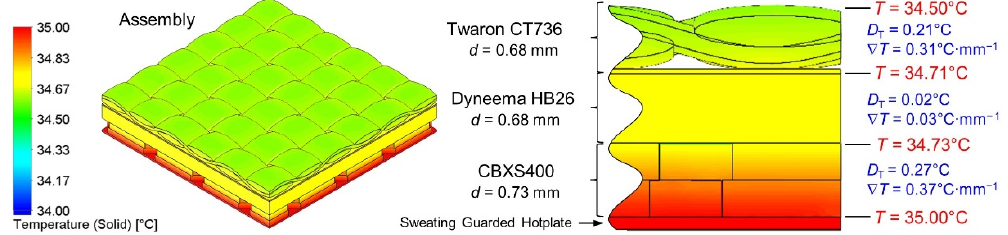
Figure 10. Temperature distributions on 3D model of assembly.